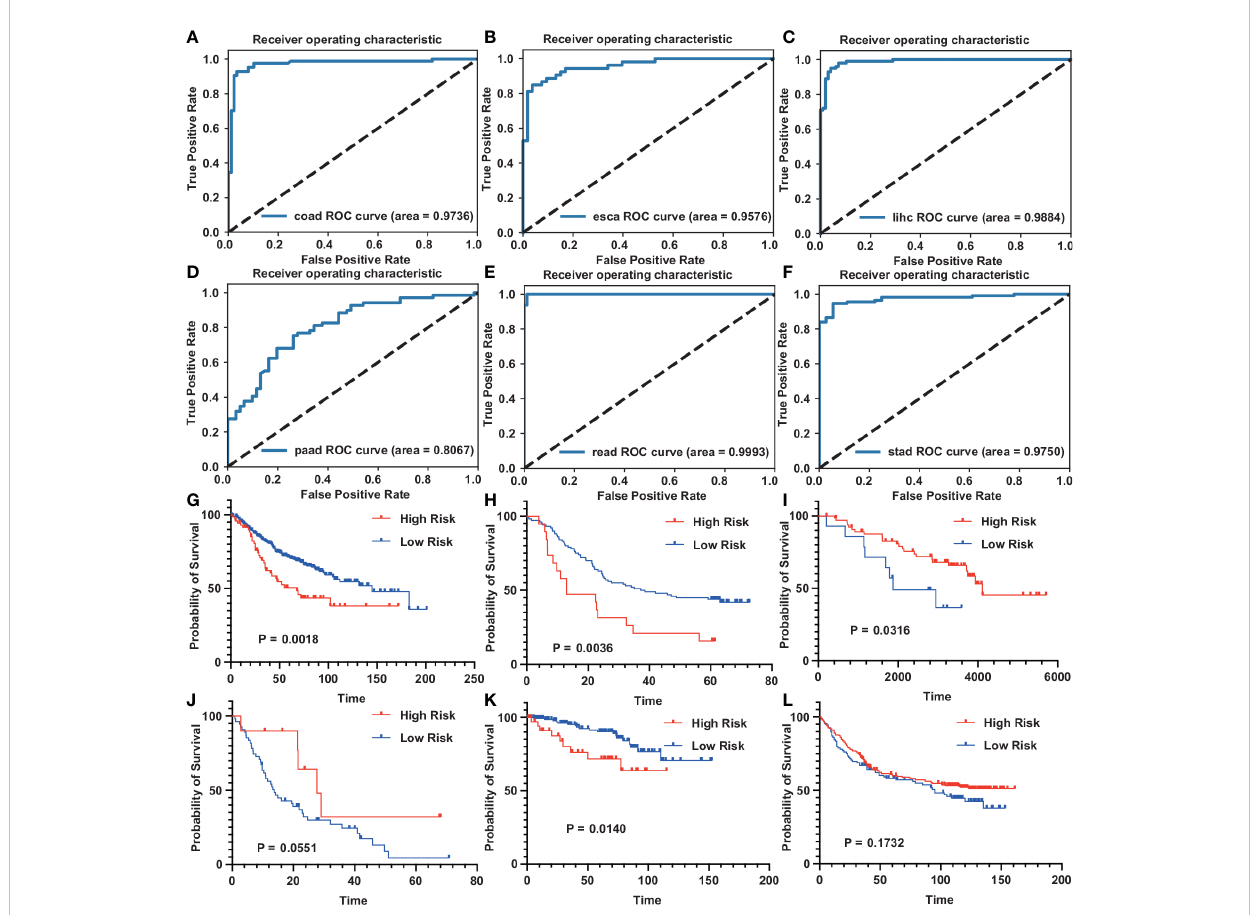
FIGURE 7 GEO datasets veri fi cation diagnostic model and prognostic model for digestive system tumors (A – F) The ROC curve of the diagnostic model on the GEO dataset. [ (A) , COAD; (B) , ESCA; (C) , LIHC; (D) , PAAD; (E) , READ; (F) , STAD]. (G – L) The survival curve of the prognostic model on the GEO dataset. [ (G) , COAD; (H) , ESCA; (I) , LIHC; (J) , PAAD; (K) , READ; (L) ,